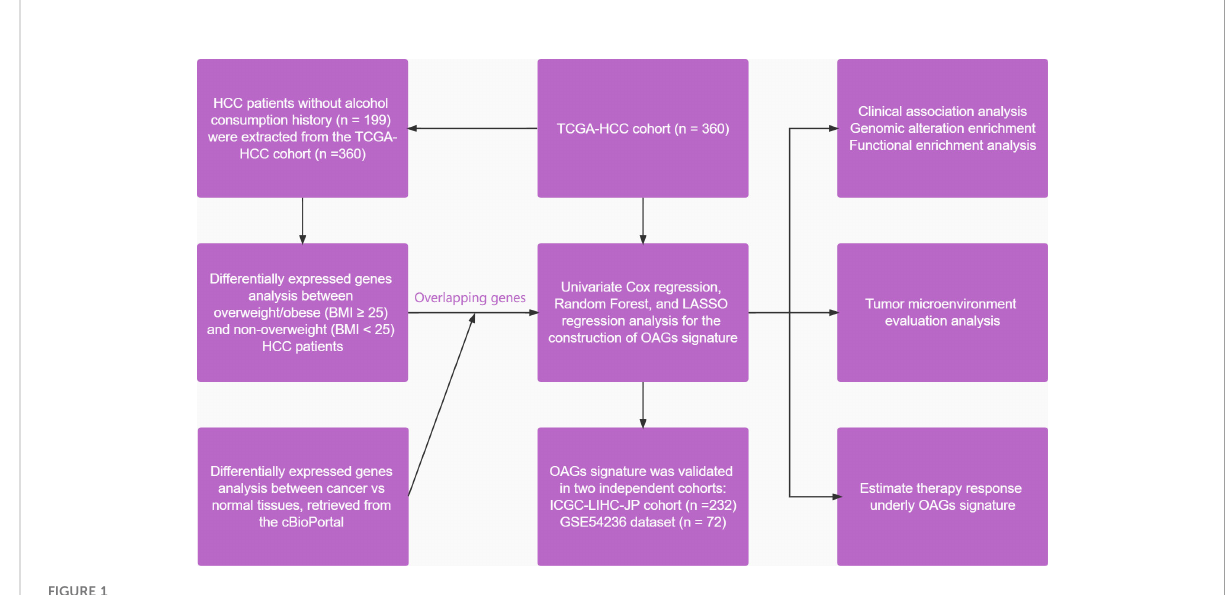
FIGURE 1 A fl owchart of study design in the present